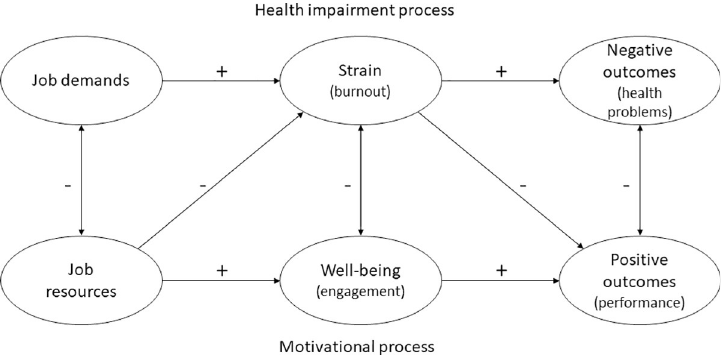
Fig 1. Job demands-resources (JD-R) model